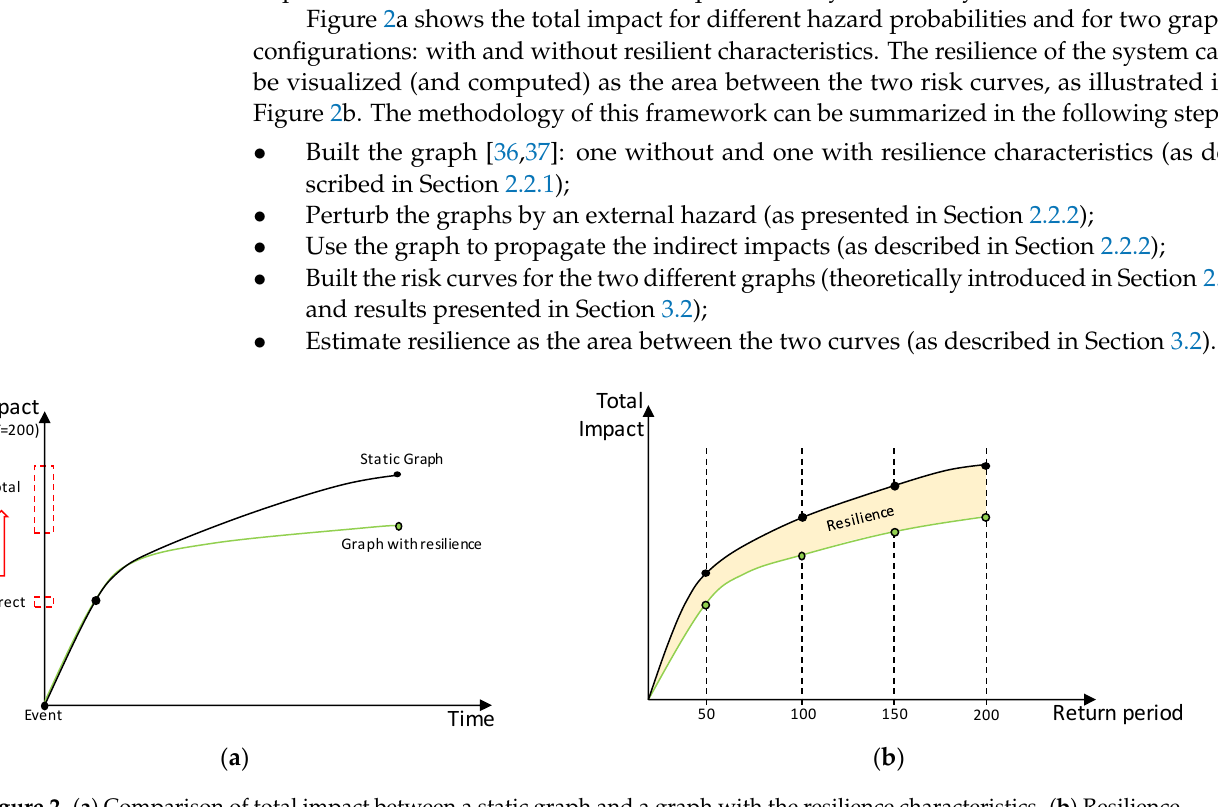
Figure 2. ( a ) Comparison of total impact between a static graph and a graph with the resilience characteristics. ( b ) Resilience representation as the area between the risk curve computed for a static graph and a graph with the resilience characteristics.